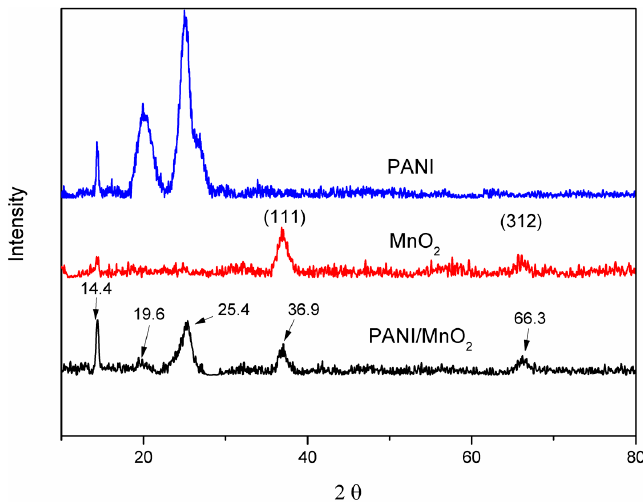
Figure 2. XRD patterns of PANI, MnO 2 and PANI/MnO 2 .